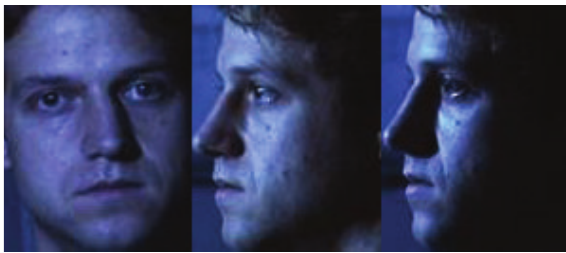
Figure 14: Example cropped images from the CMU PIE face